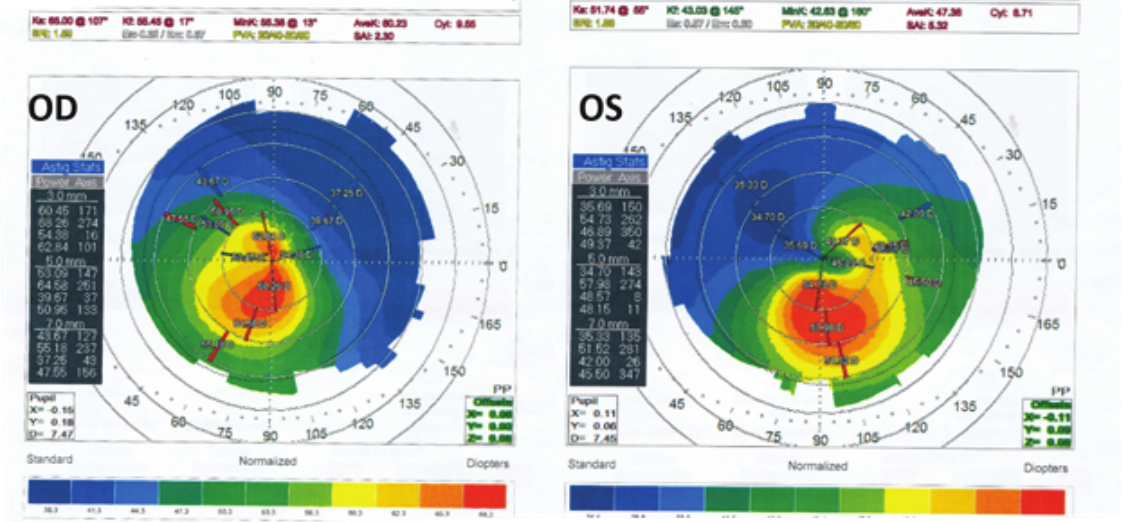
Figure 1. Placido disk-based topography showing asymmetric bow-tie patterns with skewed radial axes (SRAX) in both eyes. The steep and flat keratometry of the right eye was 65.00 D at 107º and 55.17 D at 17º, respectively. In the left eye, the steep and flat keratometry was 51.74 D at 55º and 43.03 D at 145º, respectively.